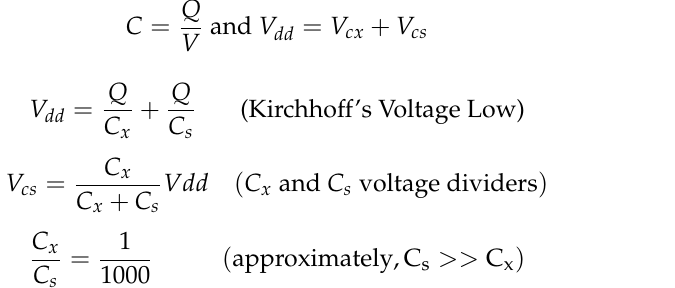
Figure 1. A simple circuit of the switch-capacitor technique.